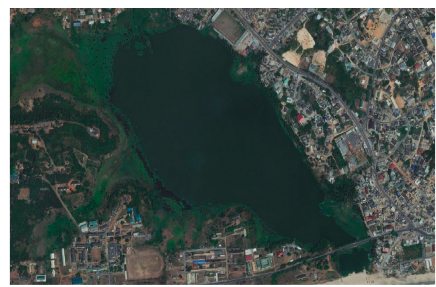
Figure 1: Aerial image of the Fosu